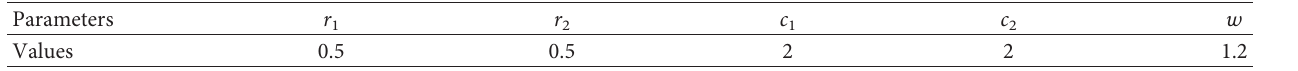
Table 4: Parameters setting of PSO.